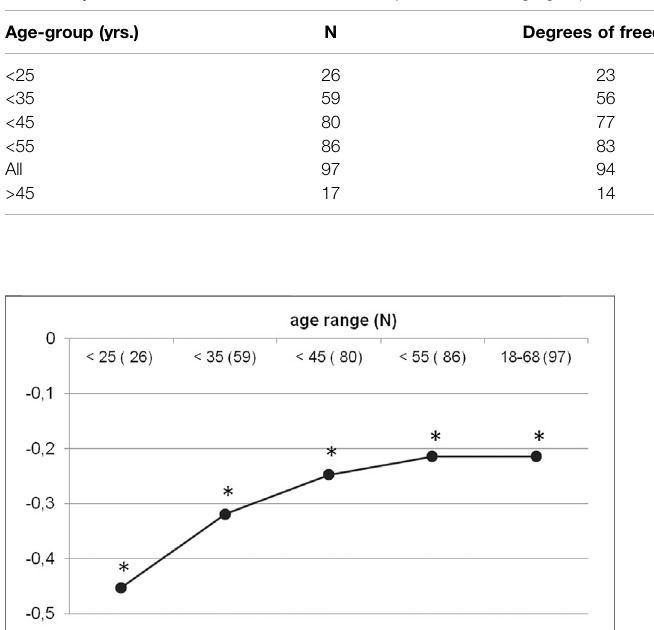
coef fi cient of the DOC was a signi fi cant predictor (Beta (cid:1) −